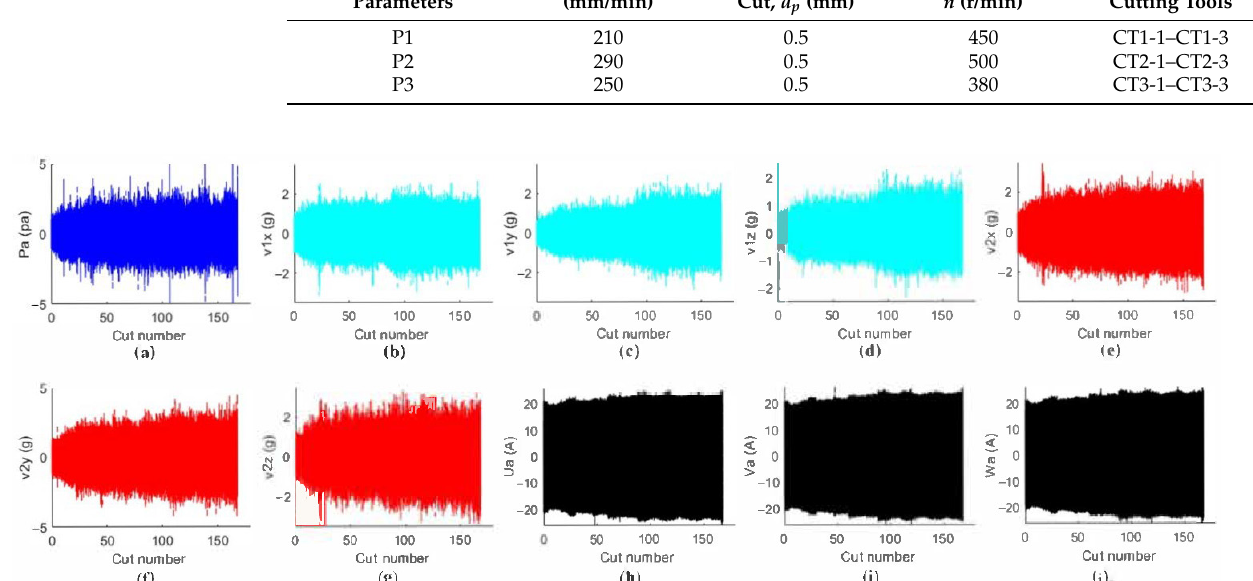
Table 3. Three groups of cutting parameters used in assembly interface machining experiment. Group No. of Cutting Parameters